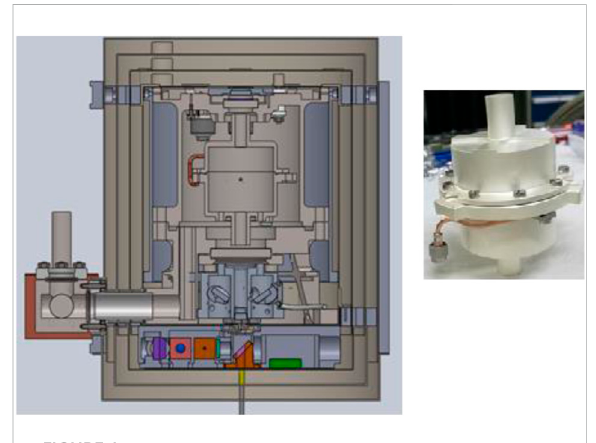
FIGURE 1 Physics package (left) and microwave cavity (right). The packageincludesavacuumchamberwhosevacuumismaintained using two ion pumps, and the chamber is covered by three layers of the magnetic shield. Inside the chamber is a cylindrical microwavecavitywhichismadeoftitaniumandcoatedwithsilver. Cesium is spread into the microwave cavity from the source. The detection laser passes through the center of the cavity from the bottom to top and re fl